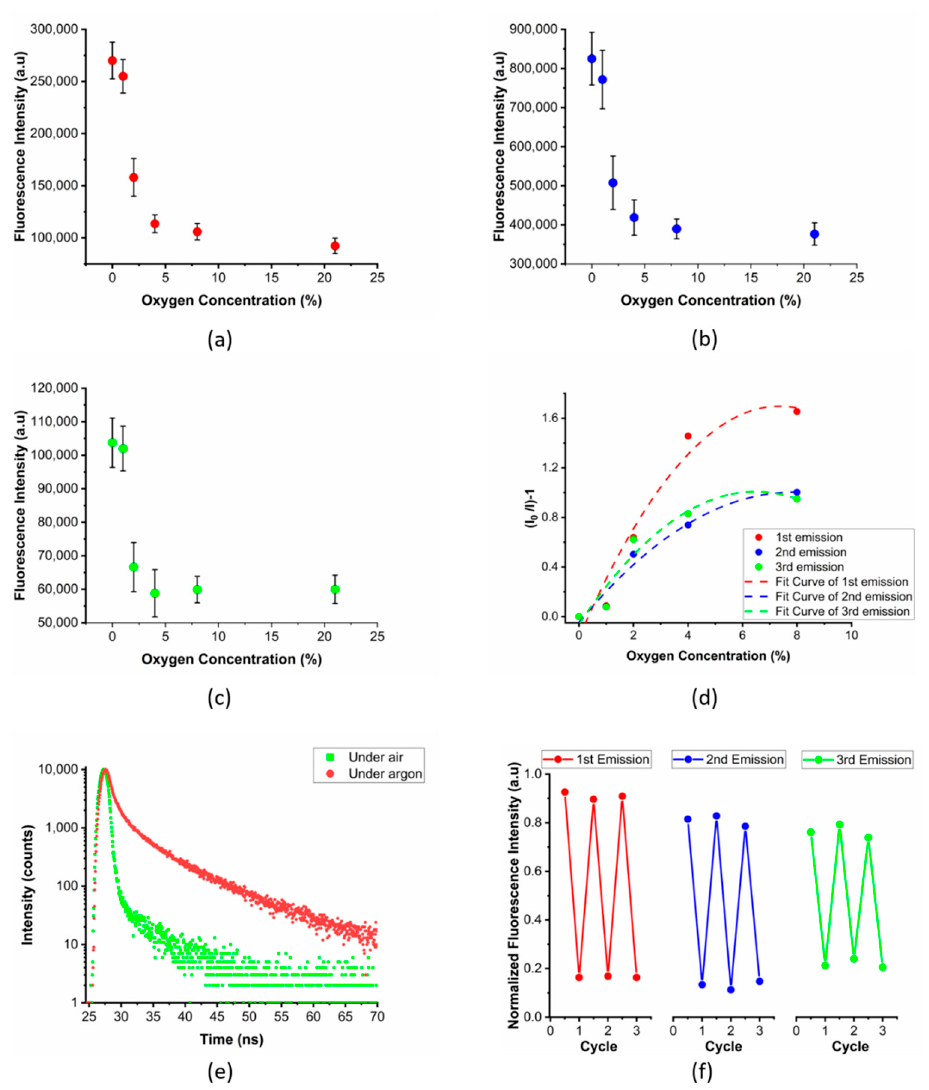
Figure 5. Fluorescence intensity of polymer films composed of U-PPD16 embedded in a PVA matrix (Mowiol 40–88) as a function of the oxygen concentrations for the emission centers of 310 nm ( a ), 400 nm ( b ) and 550 nm ( c ). ( d ) Non-linear Stern–Volmer calibration plot of each emission center and 2nd order polynomial fit. ( e ) Fluorescence emission decay curve of the functional PVA film under air and argon. ( f ) Reversibility of the functional PVA film for each emission center during three consecutive 0–21 kPa O 2 cycles.